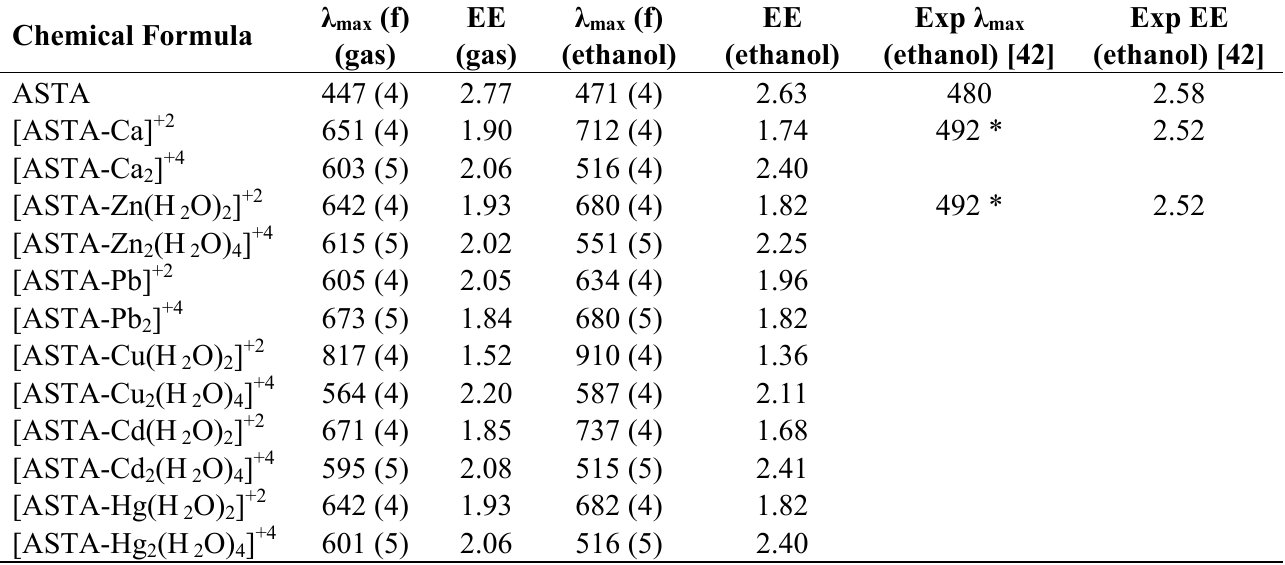
Table 1. UV/vis maximum absorption wavelength, λ as well as the correspondent excitation energy (EE in eV) calculated in gas phase and in ethanol for ASTA and the ASTA-metal cationic